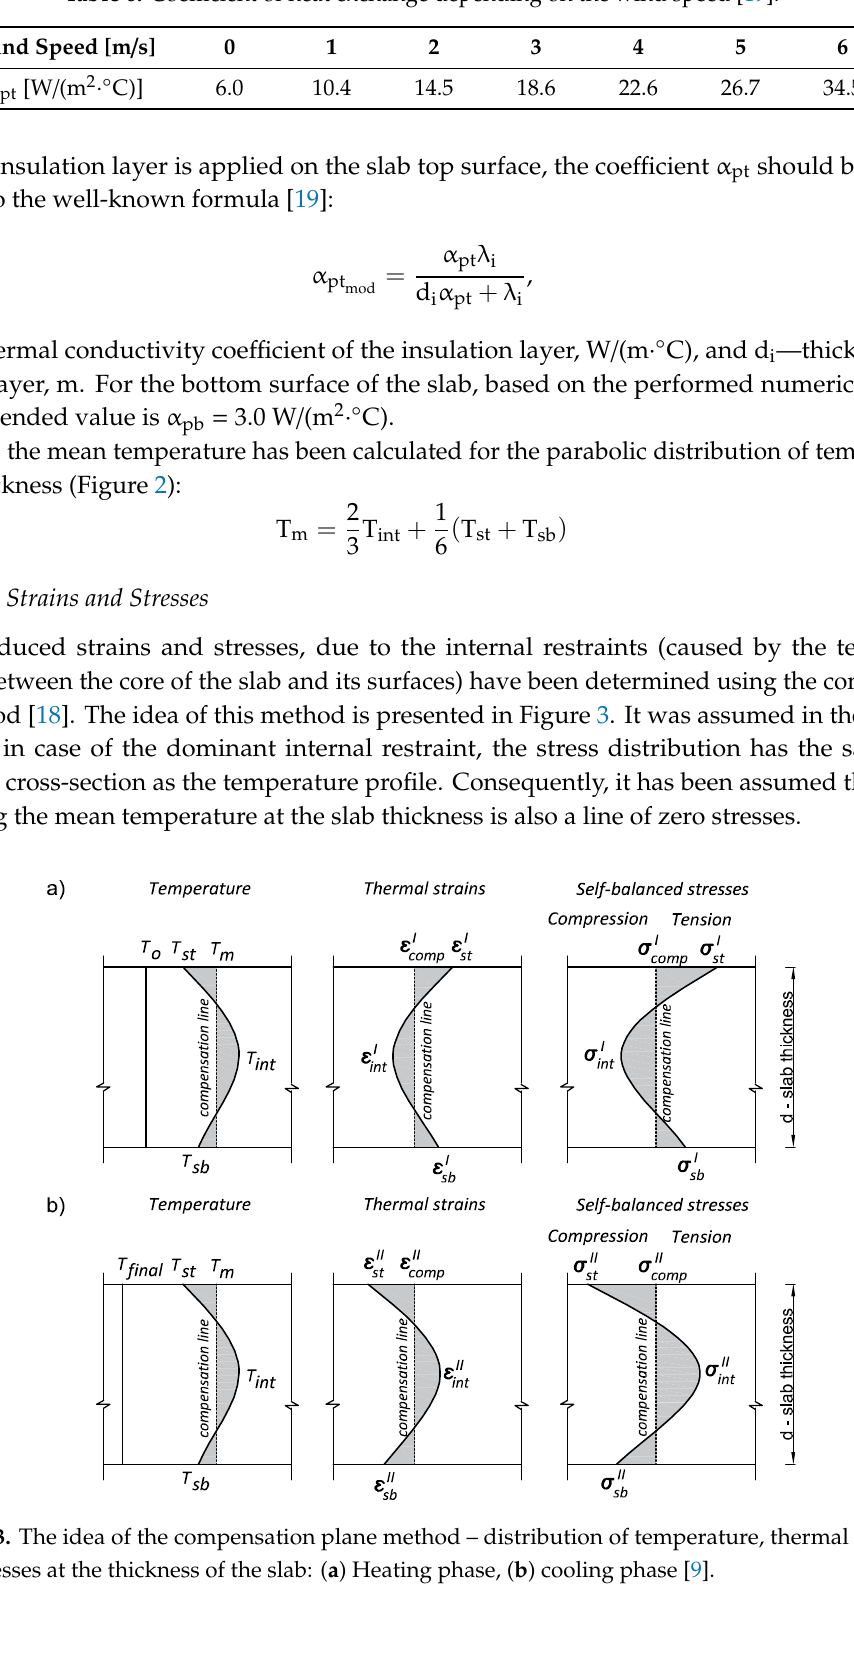
Table 6. Coe ffi cient of heat exchange depending on the wind speed [19].